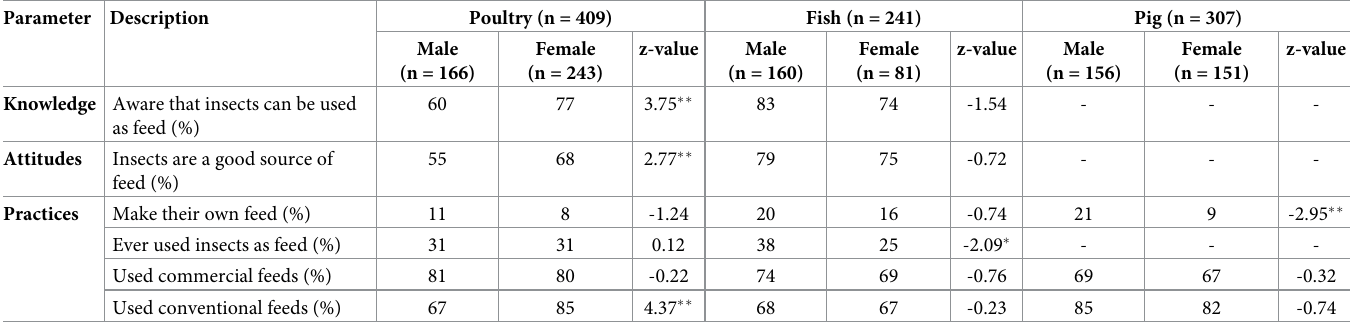
Table 3. Farmers’ knowledge, attitude and practices towards insects as an alternative source of feed for poultry, fish and pigs. Parameter Description